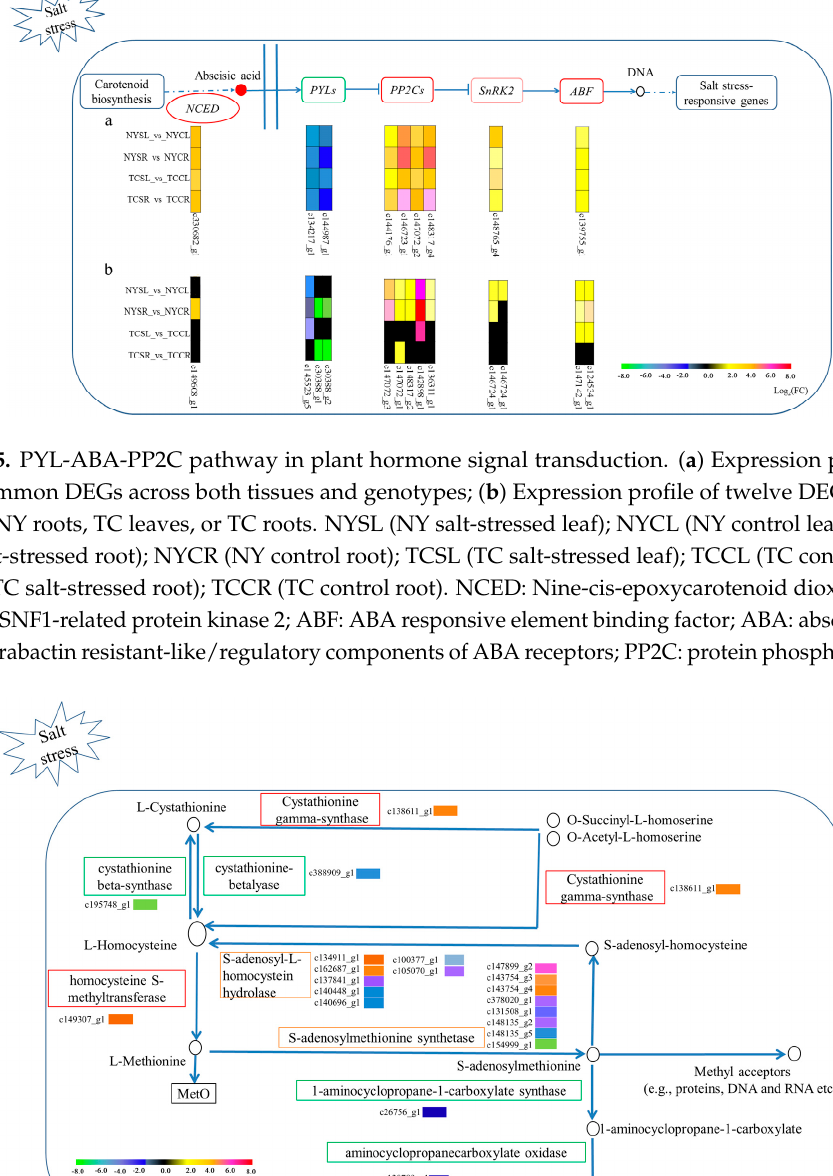
Figure 6. Methionine metabolism pathway in TC root tissue and the expression profile of 23 DEGs in the pathway.